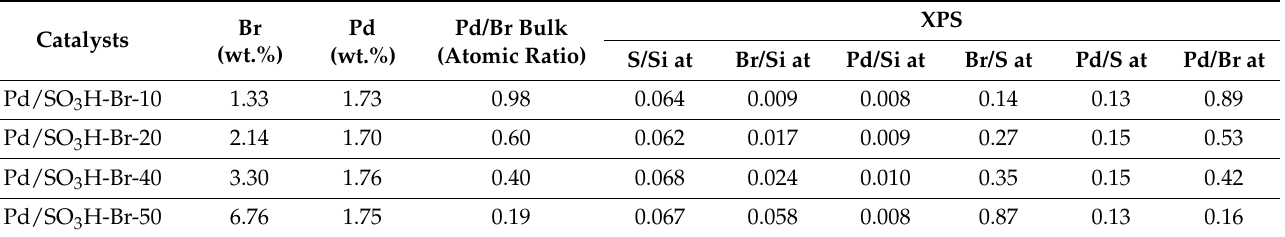
Table 2. Chemical composition determined by Total reflection X-ray fluorescence (TXRF) and